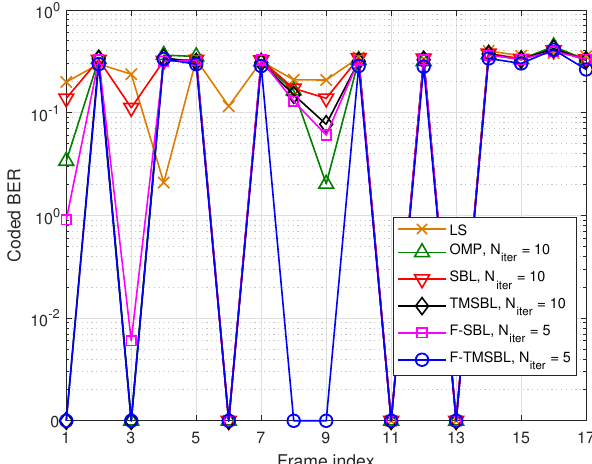
Figure 7. Coded BER performance in at-sea